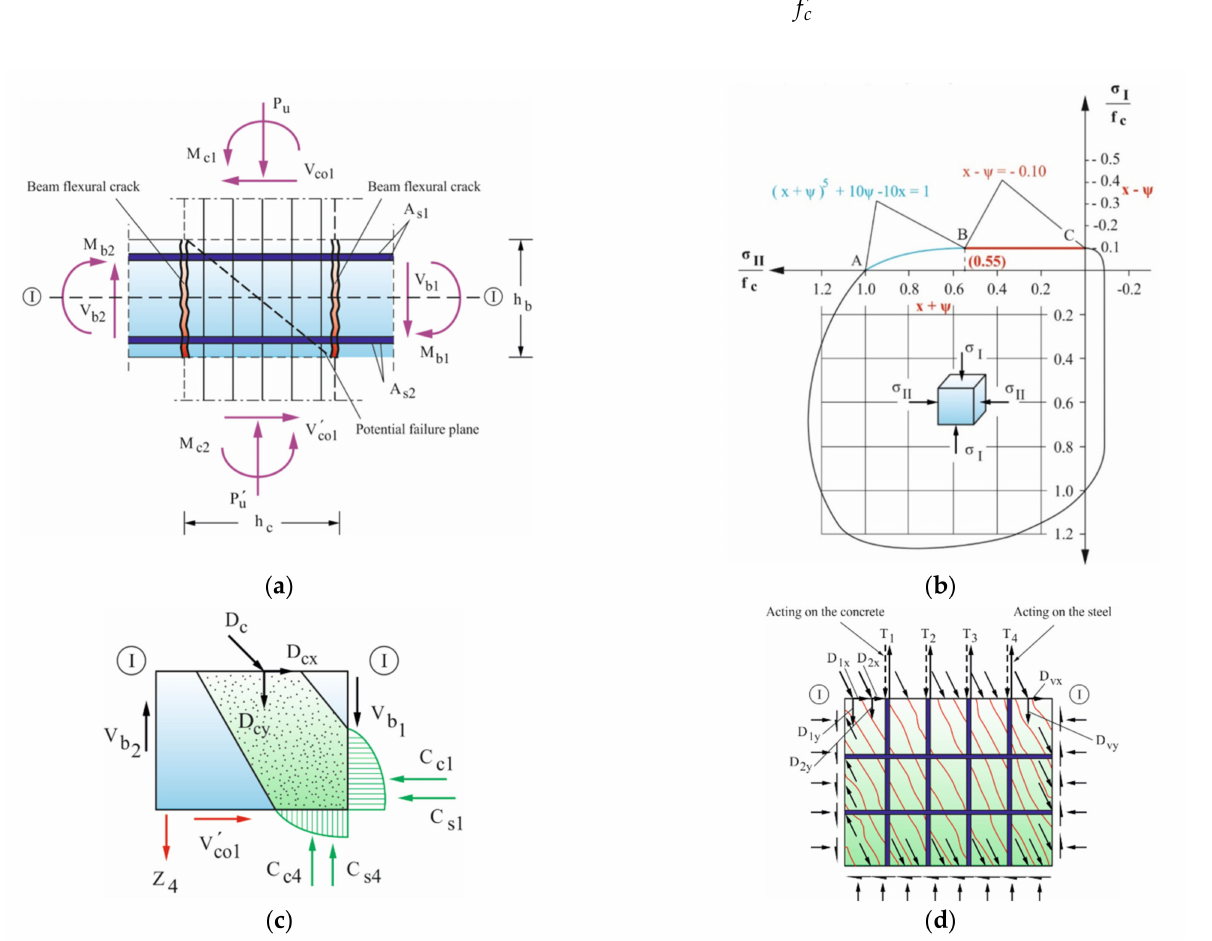
Figure 10. ( a ) Interior beam–column joint; ( b ) representation of the concrete biaxial strength curve by a parabola of 5th degree [14] and the substitute linear branch BC; ( c , d ) forces acting in the joint core concrete through section I–I from the two mechanisms (concrete compression strut ( c ) and truss mechanism ( d )). These are same for exterior beam–column